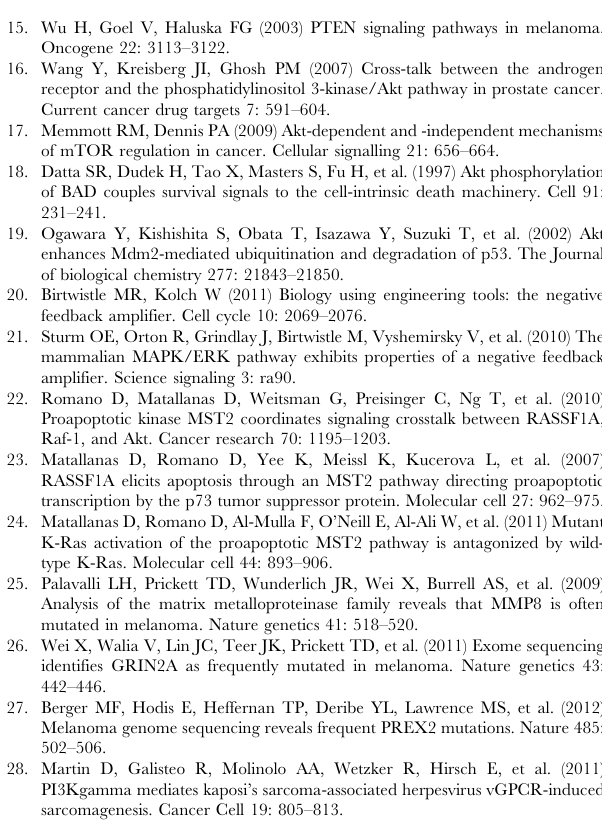
Figure S1 Sample chromatograms of Sanger-verified NFKB1 (a) and PIK3R4 (b) somatic mutations. (TIF) Table S1 Melanoma patients’ clinical data and gene mutation profiles. Table S2 454FLX variants detected in melanoma pools. Discovery, prevalence 1, and prevalence 2 pools of melanoma genomic DNA were subjected to gene mutation